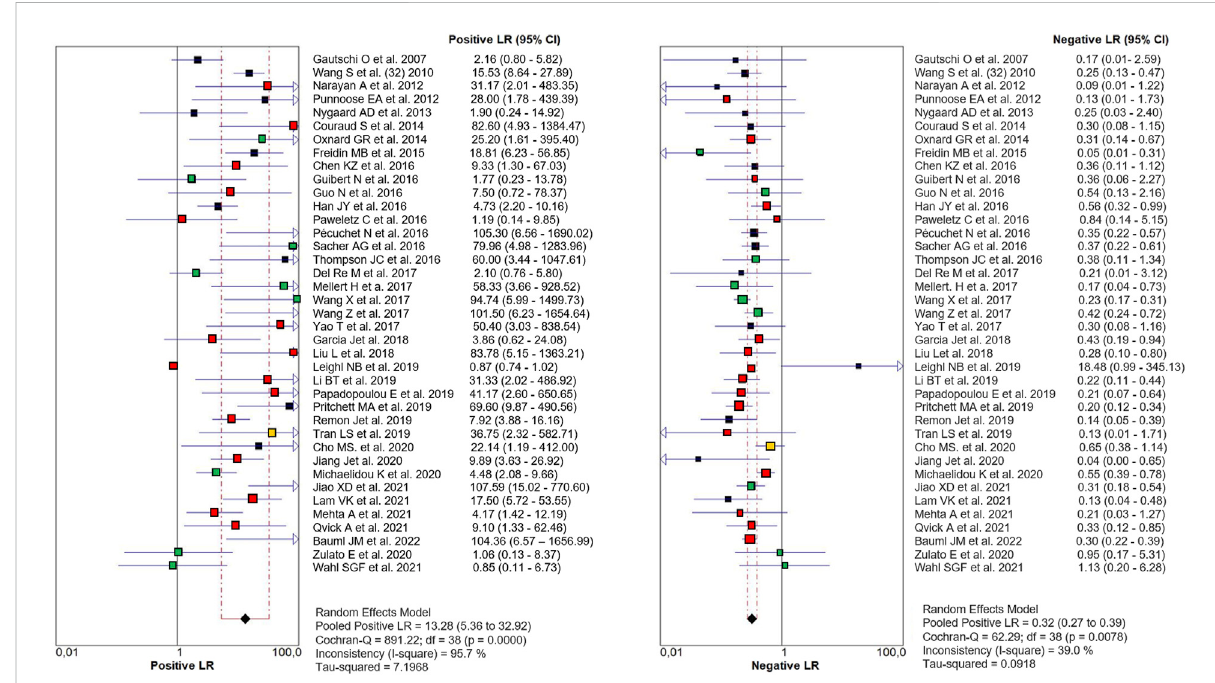
FIGURE 3 Paired Forest plot of PLR and NLR of cfDNA testing in detecting KRAS mutation in NSCLC for 39 studies in the meta-analysis. Random-effects (RE)modelused.Thesquareandhorizontalbarsrepresentedstudy-speci fi cPLRandNLRand95%con fi denceinterval(CI).Squaresindifferentcolors represent a different diagnostic method (red = Targeted NSG; blue = ddPCR; yellow = both; black = other method). Diamonds represented the overall results. The pooled PLR and NLR were 8.32 (95% CI 6.93 – 9.99) and 0.29 (95% CI 0.26 – 0.33),